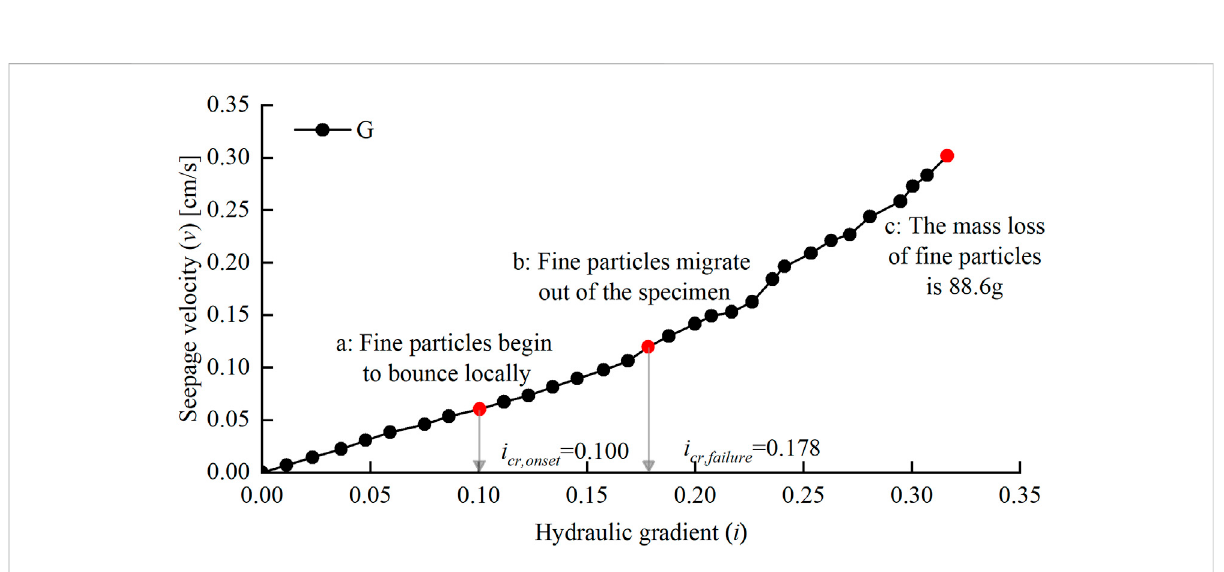
FIGURE 6 i – v curve for unreinforced gap-graded